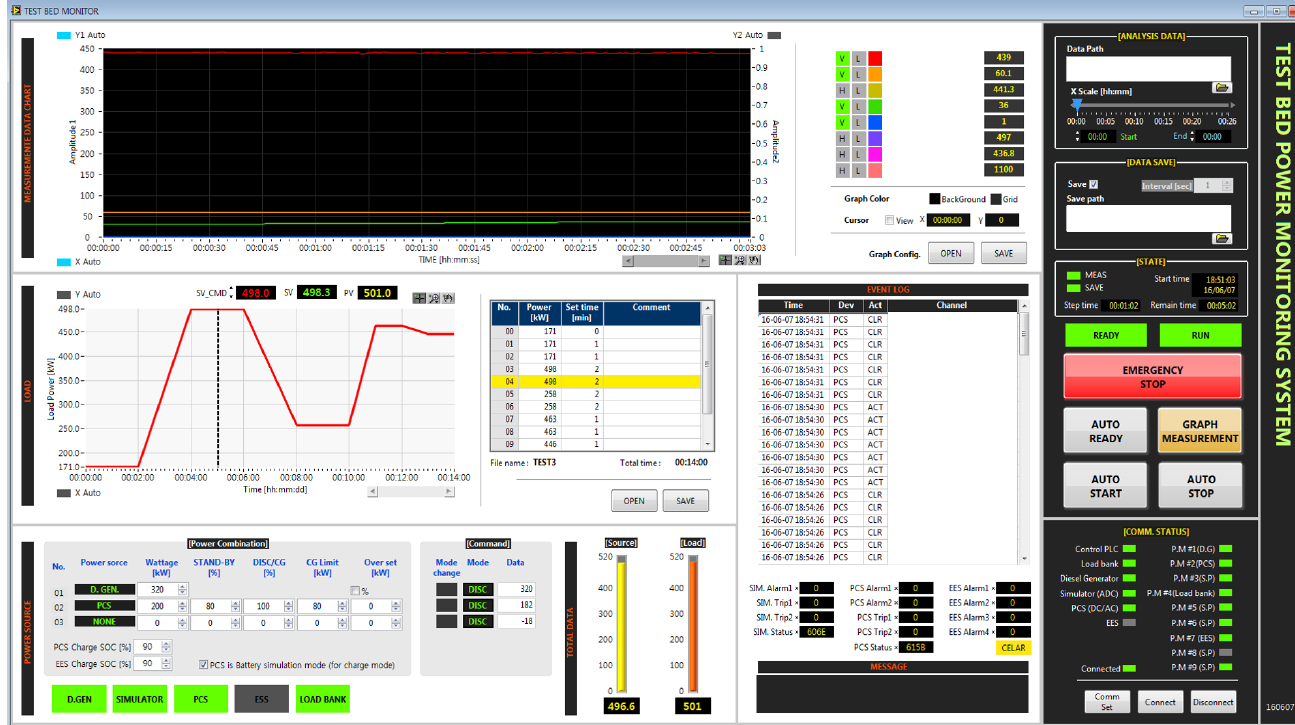
Figure 14. The monitoring system in the testbed.